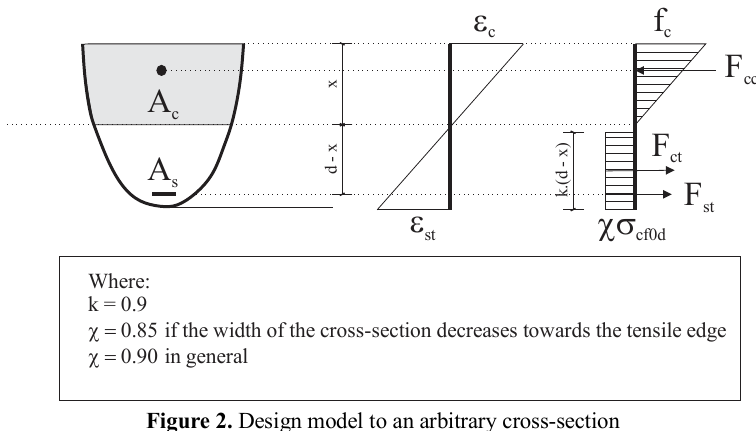
Figure 2. Design model to an arbitrary